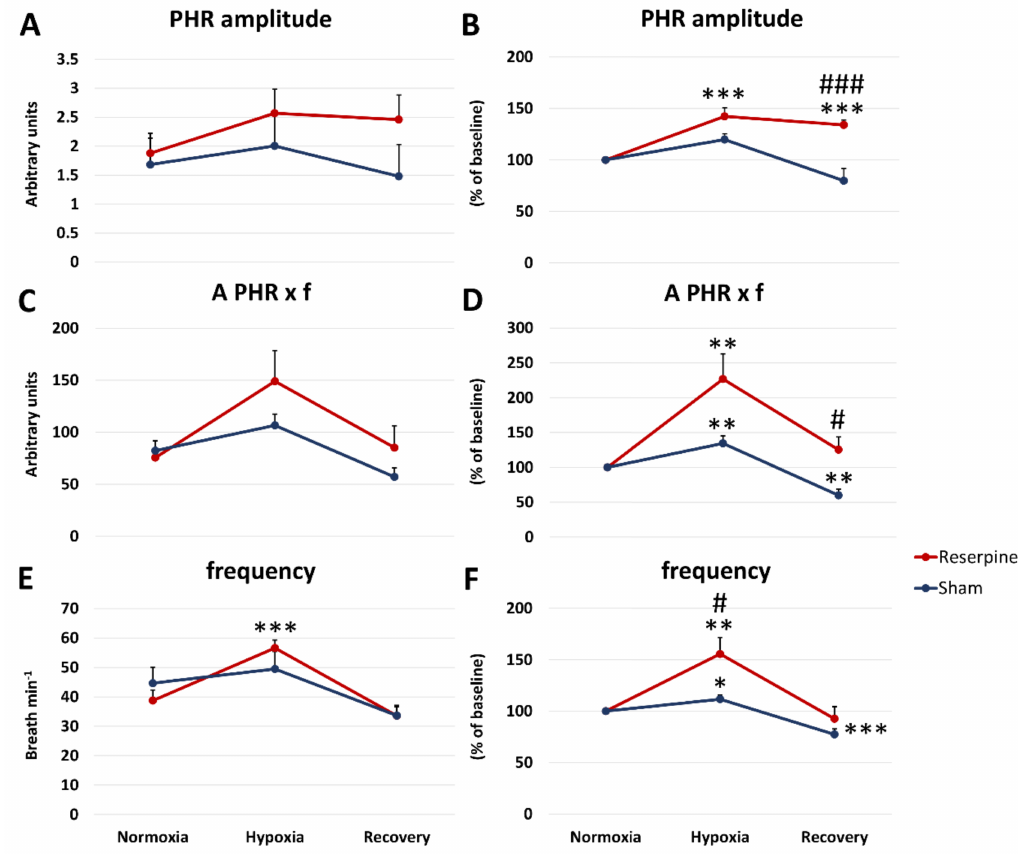
Figure 3. The changes in amplitude ( A , B ), minute activity (A × f) ( C , D ), and frequency of discharge (f) ( E , F ) of the phrenic nerve (PHR) during normoxia, hypoxic ventilatory response, and recovery in animals subjected to a vehicle (sham) or reserpine injection. Results are expressed as absolute values ( A , C , E ) and percentage of the baseline nerve activity (considered 100%) ( B , D , F ) before hypoxia. All values are means ± SEM. *# P < 0.05; **## P < 0.01, ***### P < 0.001, *—statistical significance in comparison to normoxic value, #—statistical significance between corresponding values in reserpine and sham groups ( n = 7–9 per